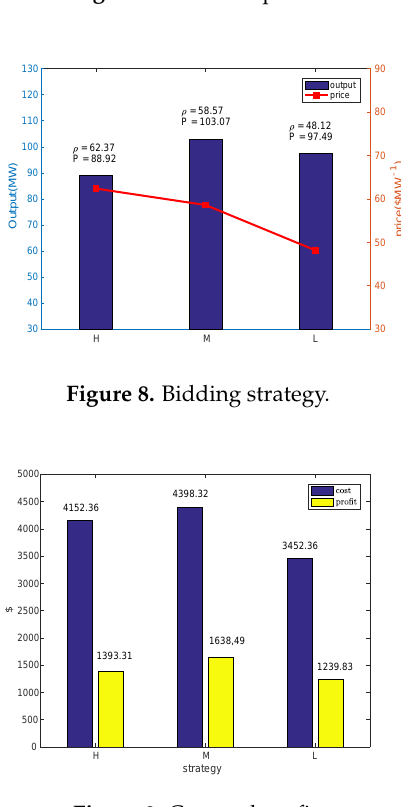
Figure 7. Cost and profit.